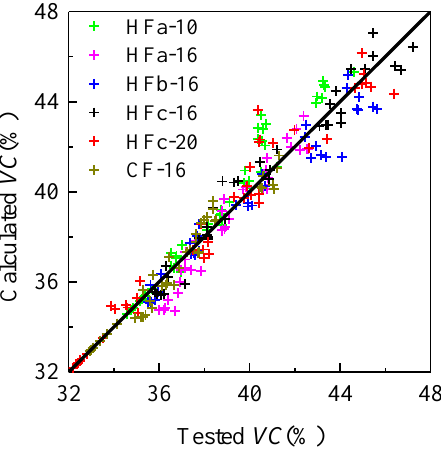
Figure 4. Comparison of tested and calculated values of void content VC.